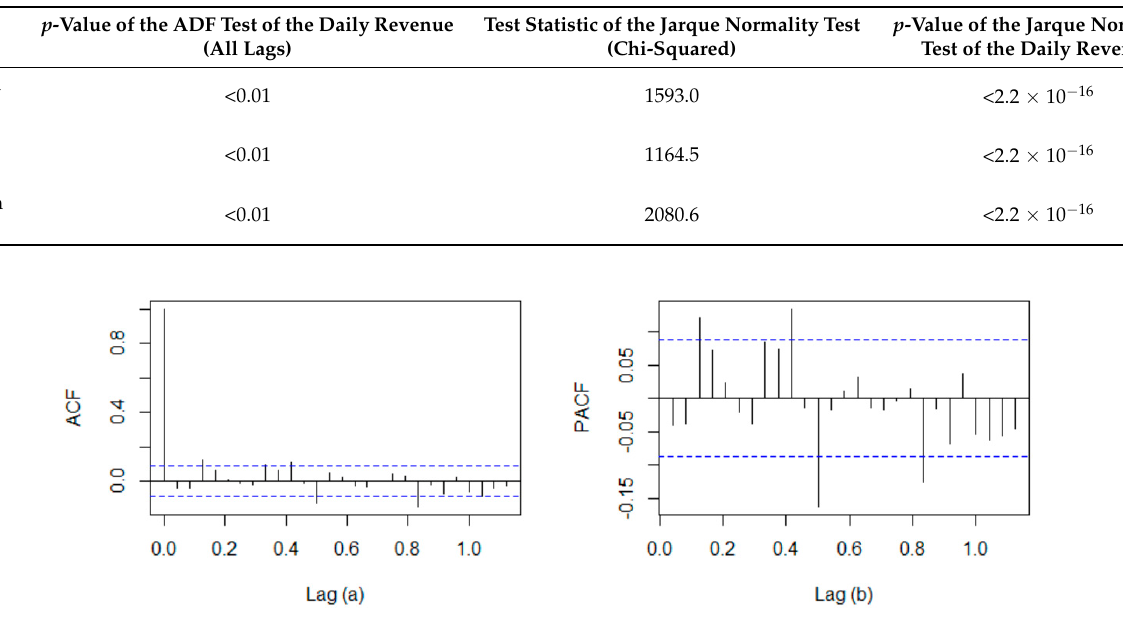
Figure 9. ( a ) ACF plot after the first-order difference of the Shanghai Index. ( b ) PACF plot after the first-order difference Figure 9. Lag ( a ) ACF plot after the first-order difference of the Shanghai Index. Lag ( b ) PACF plot after the first-order of the Shanghai Index. difference of the Shanghai